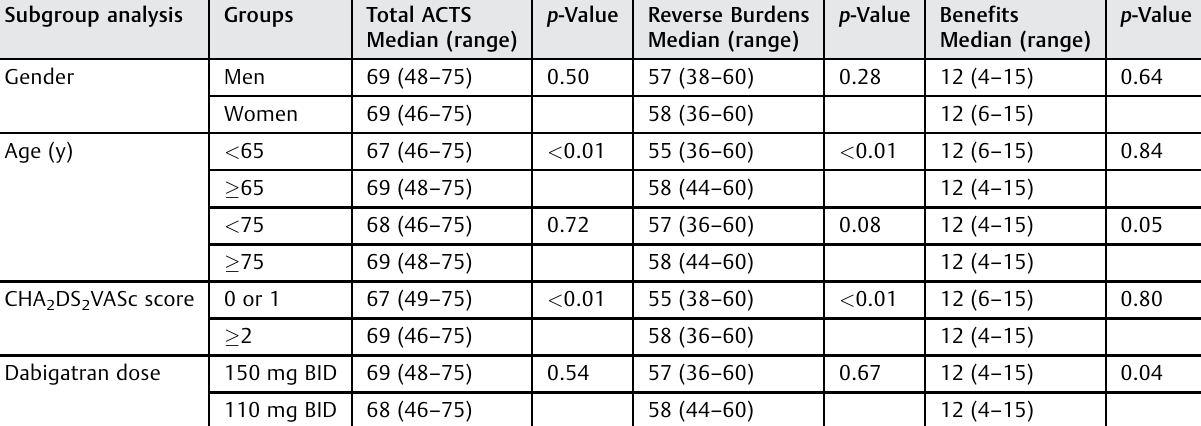
Table 2 Subgroup analysis Subgroup analysis